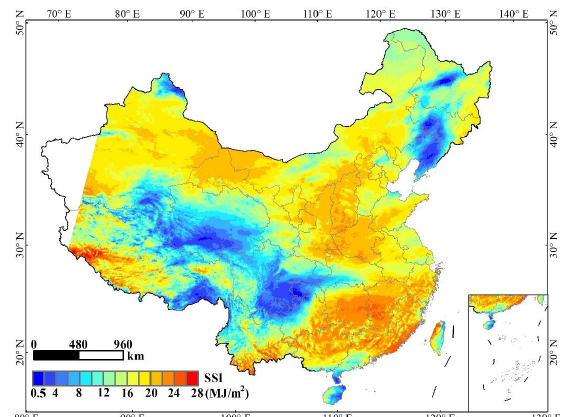
Figure 6 . Spatial distribution of the daily global SSI estimated by the Gaussian fitting method on September 23, 2016.